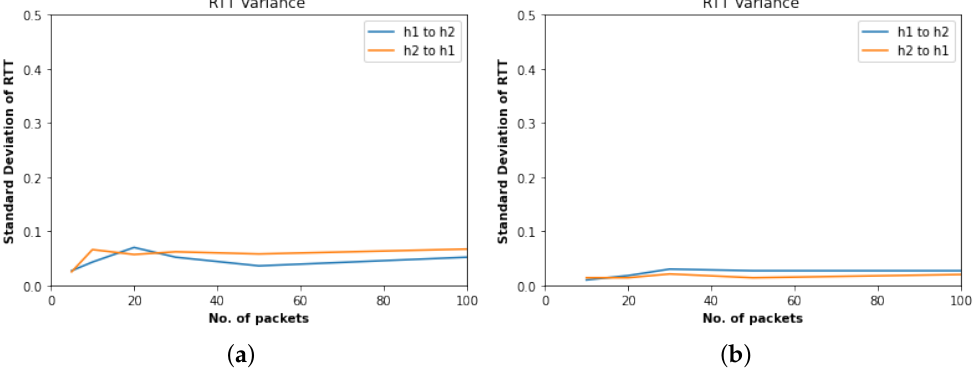
Figure 11. RTT Variance, ( a ) in Legacy (AS65000 as transit) and ( b ) AS65000/SDN as Transit in